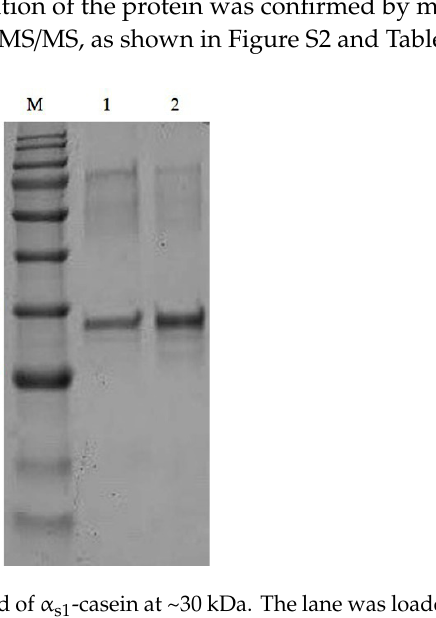
Figure 7. SDS-PAGE showed a single band of α s1 -casein at ~30 kDa. The lane was loaded with different protein concentrations: Lane 1:10 μg/mL, Lane 2:20 μg/mL, M: Protein